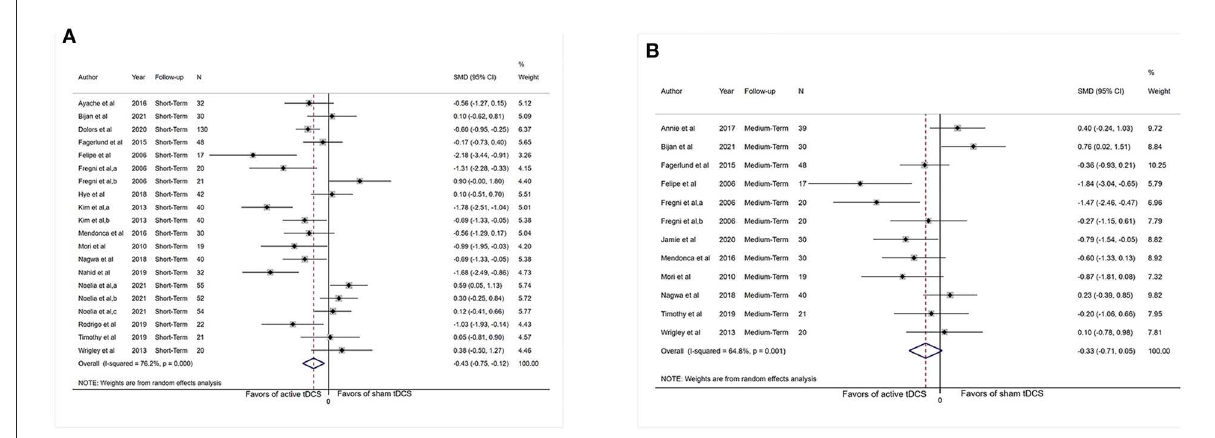
FIGURE2 Forest plot showing overall effect sizes (Hedges’ g) of real tDCS on pain intensity within studies. These plots show the pooled SMD (large diamond shape) and I 2 resulting from the meta-analysis. (A) Pain scores from short-term data. (B) Pain scores from medium-term data. CI, confidence interval; SMD, standard mean difference; tDCS, transcranial direct current stimulation; a, motor cortex; b, dorsolateral prefrontal cortex; c, operculo-insular cortex.